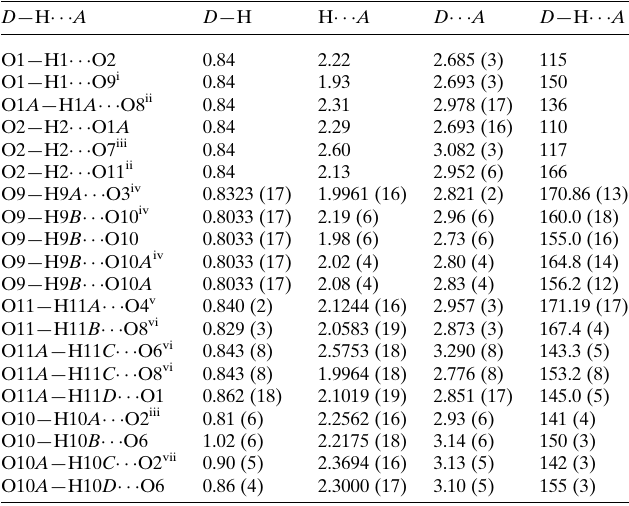
Table 1 Hydrogen-bond geometry (A˚ , (cid:5) ) for Li 2 (tiron) (cid:2) 2.5H 2 O. D —H (cid:2)(cid:2)(cid:2) A